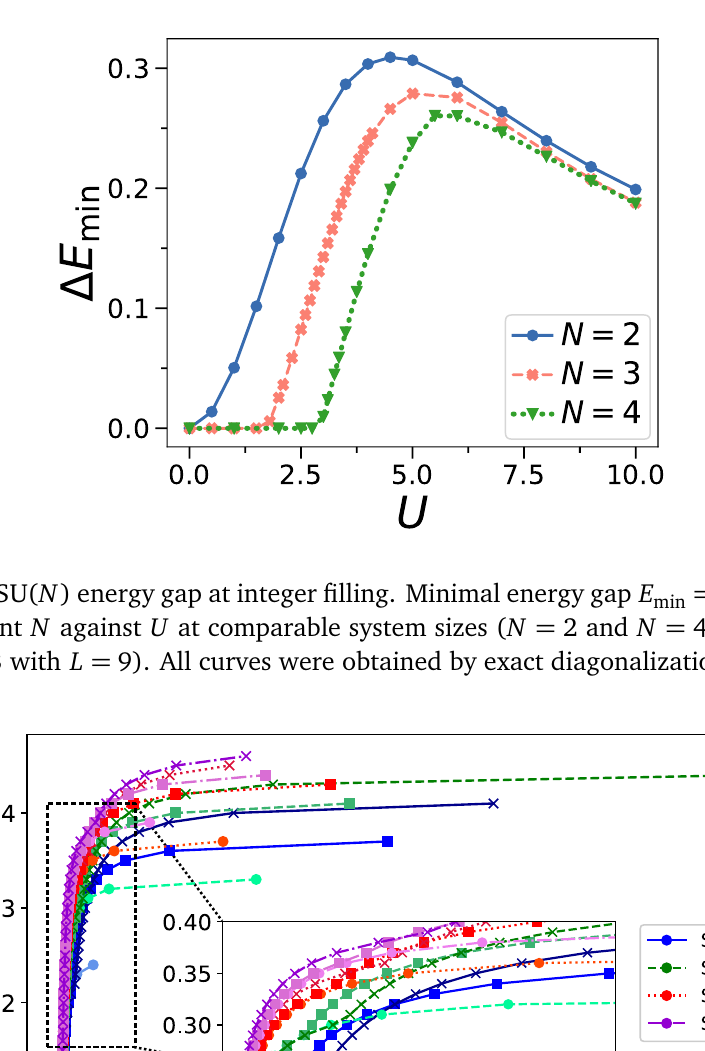
Figure 8: Figure of merit for spinon creation in the ground state of SU( N ) fermions against the interaction per particle U / N . We consider the minimum value of U re- p quired for spinons to be created in the ground state for a given value of φ ; all the values of φ where a spinon is created are recorded. The displayed curves are cal- − φ | at which the state with no spinons culated by monitoring all the distances | φ s d crosses states with any spinon configurations where φ is the flux at which spinons s are created and φ is the degeneracy point. The inset contains the data in the inter- d mediate regime. The discontinuities observed in the intermediate U / N regime when p / N > 1, are more pronounced for larger values of N / N for a system with the same N p p N but different N . All the presented results are obtained by Bethe ansatz of Gaudin- p = 1(circles), 2(squares), 3(crosses) per Yang-Sutherland model for L = 40, with N p spin component, with N = 2, 3, 4,